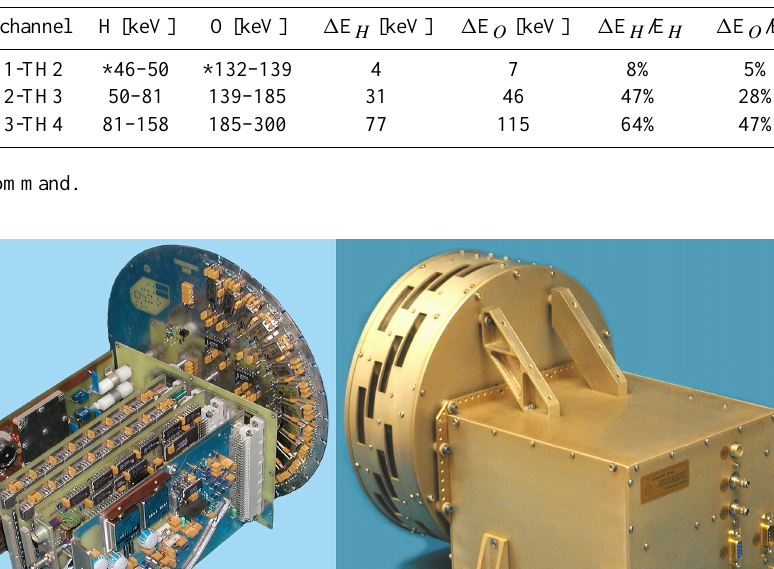
board called FRONT, situated in the Sensor Head (see also Sect.